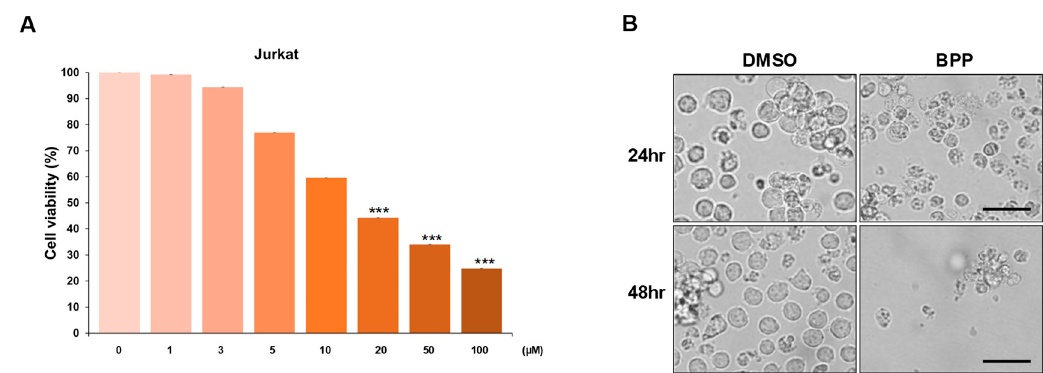
Figure 4. ( A ) BPP-induced antiproliferative effects on Jurkat cells. Cell viability was determined using an MTS assay 48 h post treatment. ( B ) The BPP (20 μ M)-treated Jurkat cells showed morphological changes 24 and 48 h post treatment. Live cells are round in